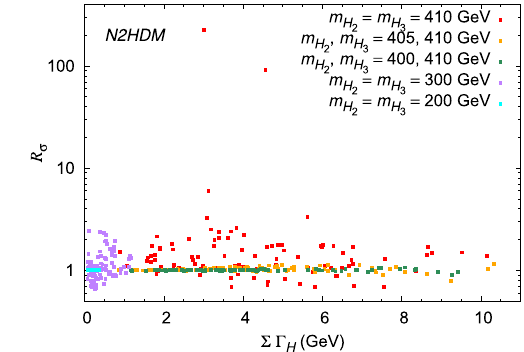
the cross sections b and c against the sum of the widths of H 2 and H 3 = m = 410GeV, corresponding to for the points obtained from the five N2HDM scans with different m H H 2 2 . Right – The ratio of and m H 3 3